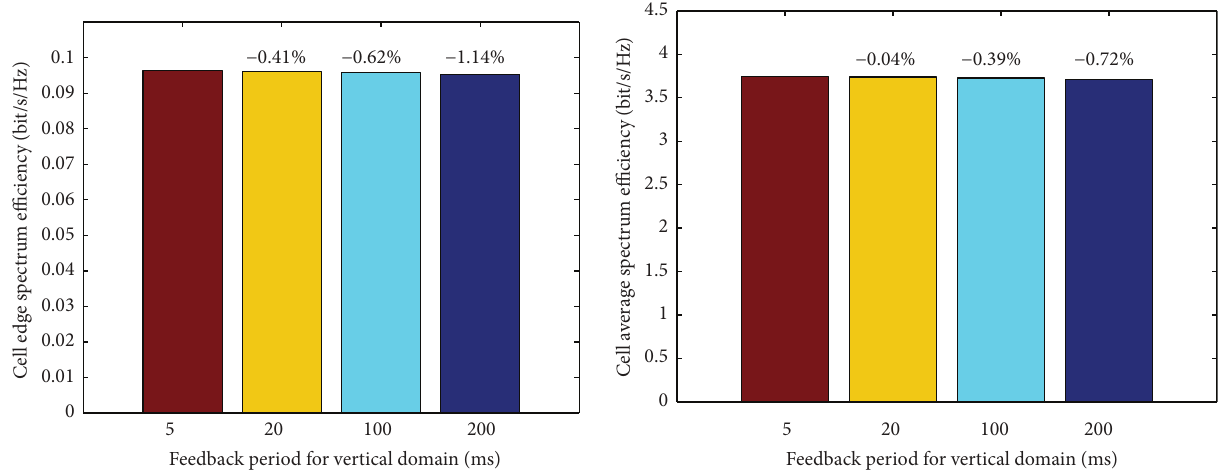
Figure 11: Feedback period for vertical domain with different values in 3D-UMi scenario.